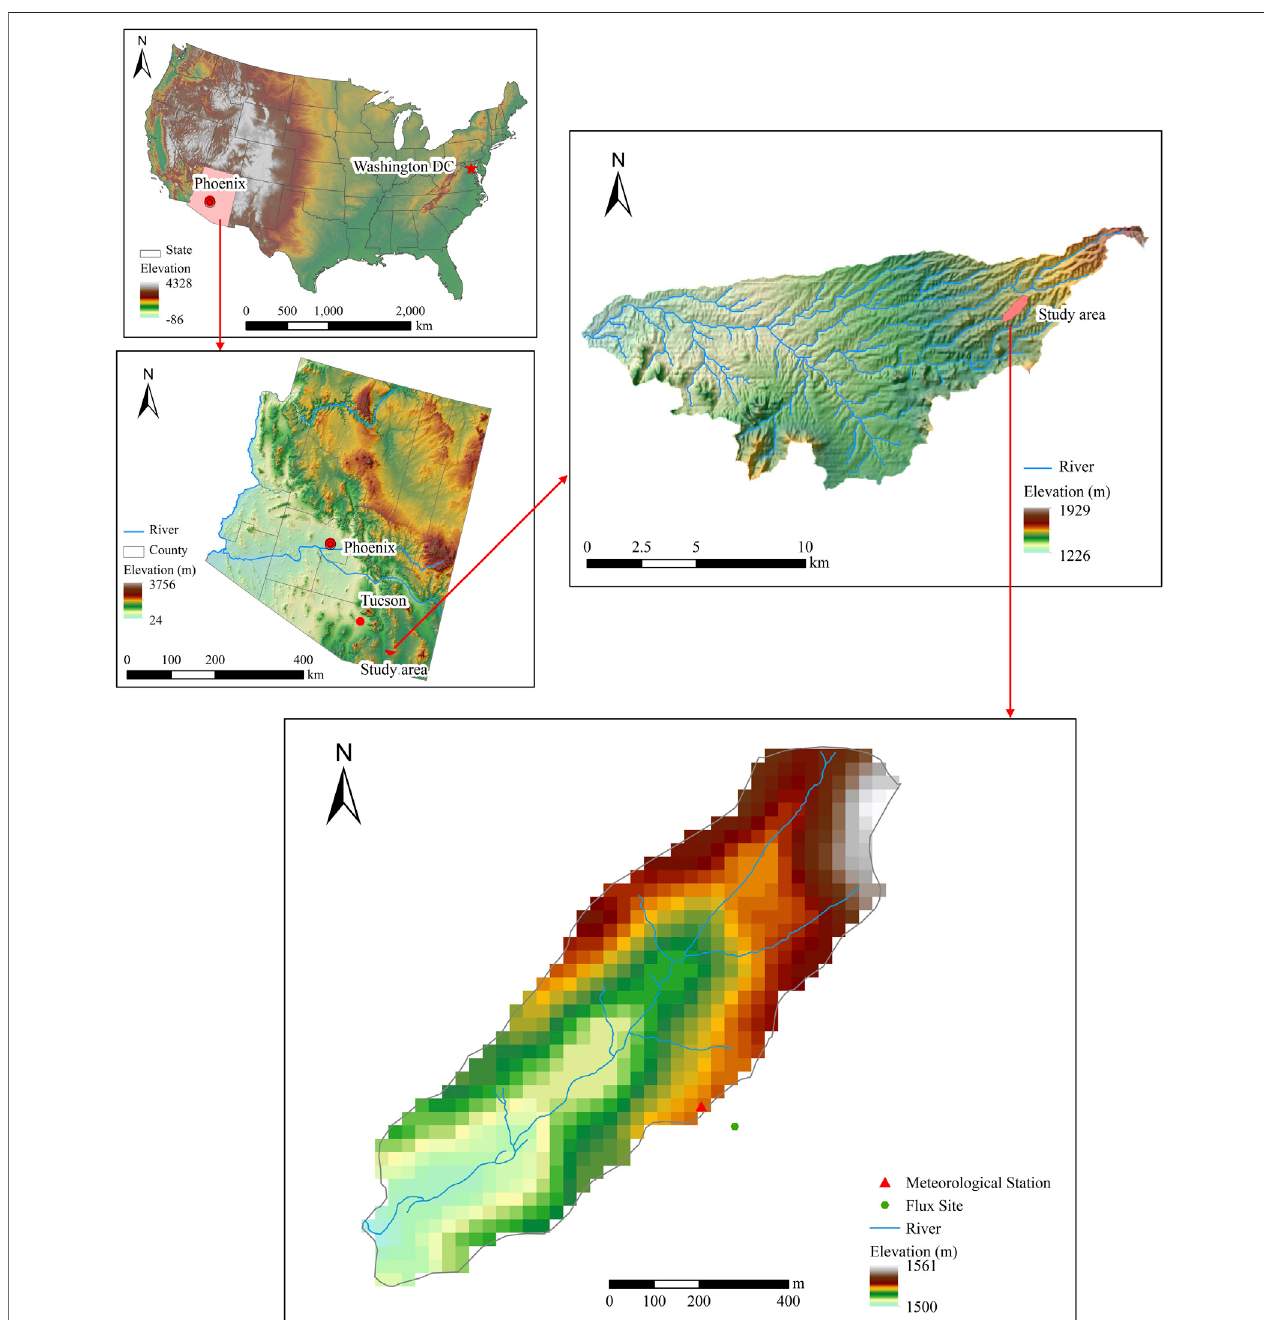
FIGURE 2 | Location of study area and observation